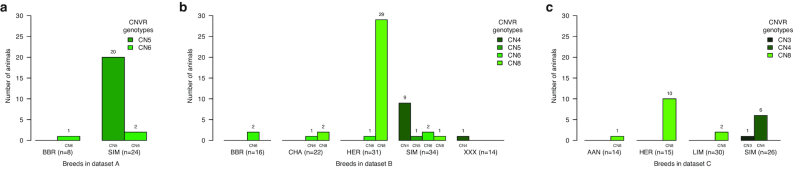
Prevalence and genotypes of the KIT locus CNV across breeds and datasets. The breed-wise prevalence and genotypes at CNVR Chr6:71,747,001–71,752,000, found ∼45 kb upstream of the KIT gene, are depicted here. This CNVR has been reported to be associated with the piebald coat colour phenotype in HER and some SIM cattle, and occurs in high copy numbers in these breeds. The reason for detection of this CNVR in high copy number in 2 of the 22 CHA cattle in dataset B is attributed to potential issues with sourcing or handling of the respective samples.